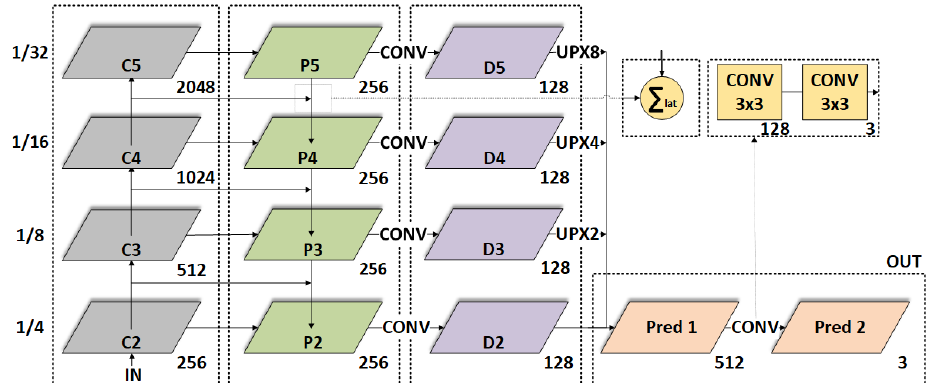
Figure 1. The connection diagram between the layers of the custom FPN used for low level point loud processing: bottom-up path (gray), top-down layers (green), fused feature map with lateral connections (mauve), two successive convolution operators (yellow) for the top layer, and the final prediction-upsample portion